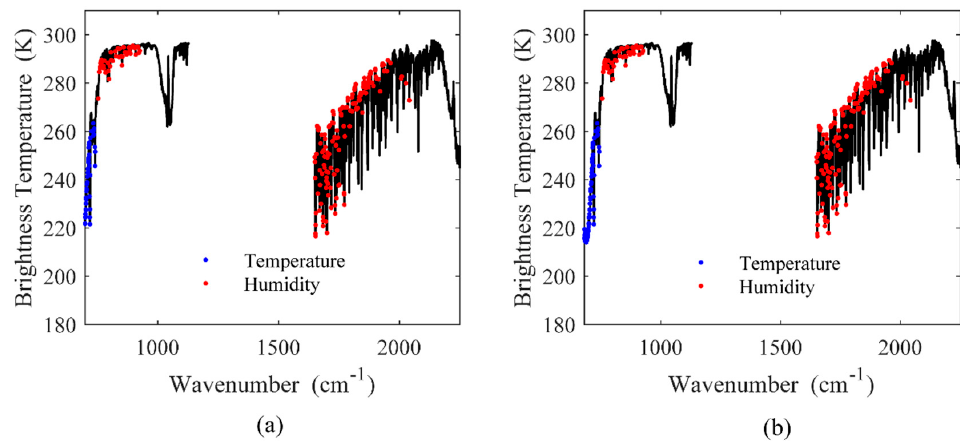
Figure 3. The distribution of the selected channels of the four groups: ( a ) FY − 4A; ( b ) FY − 4B.